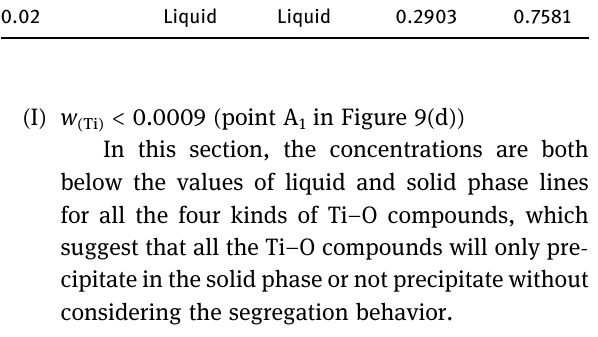
Table 7: Solid fraction for the precipitation of different Ti – O com - pounds with various Ti concentration at the cooling rate of 1 In this section, the concentrations are both below the values of liquid and solid phase lines for all the four kinds of Ti – O compounds, which suggest that all the Ti – O compounds will only pre - cipitate in the solid phase or not precipitate without considering the segregation behavior.